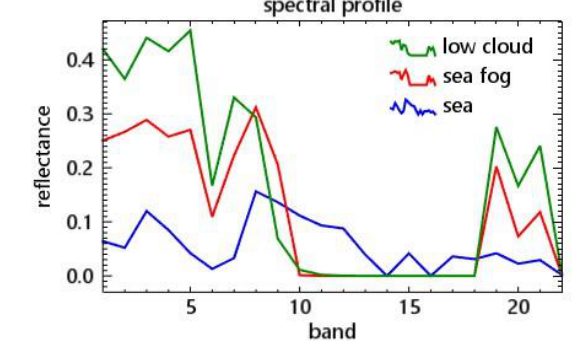
Figure 5. spectra characterization of MODIS reflectance